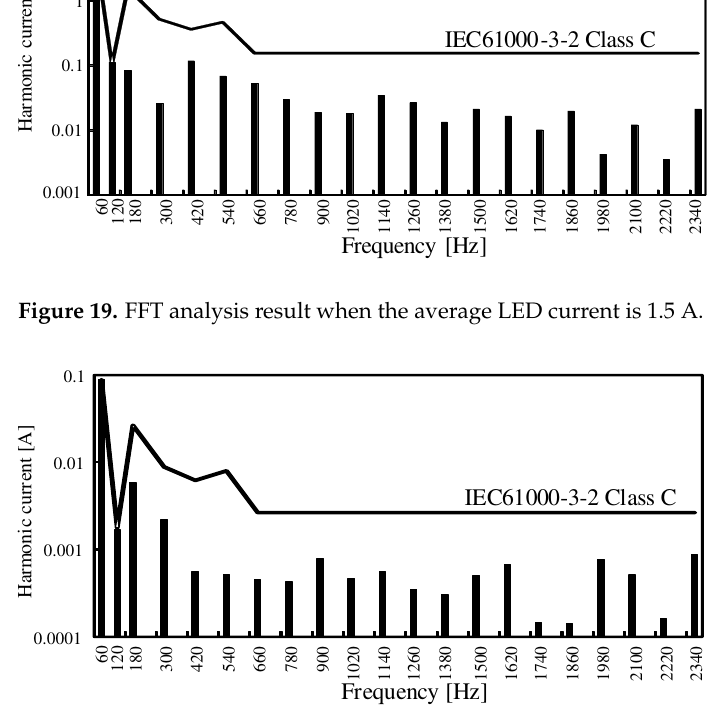
Figure 20. FFT analysis result when the average LED current is 15 mA.